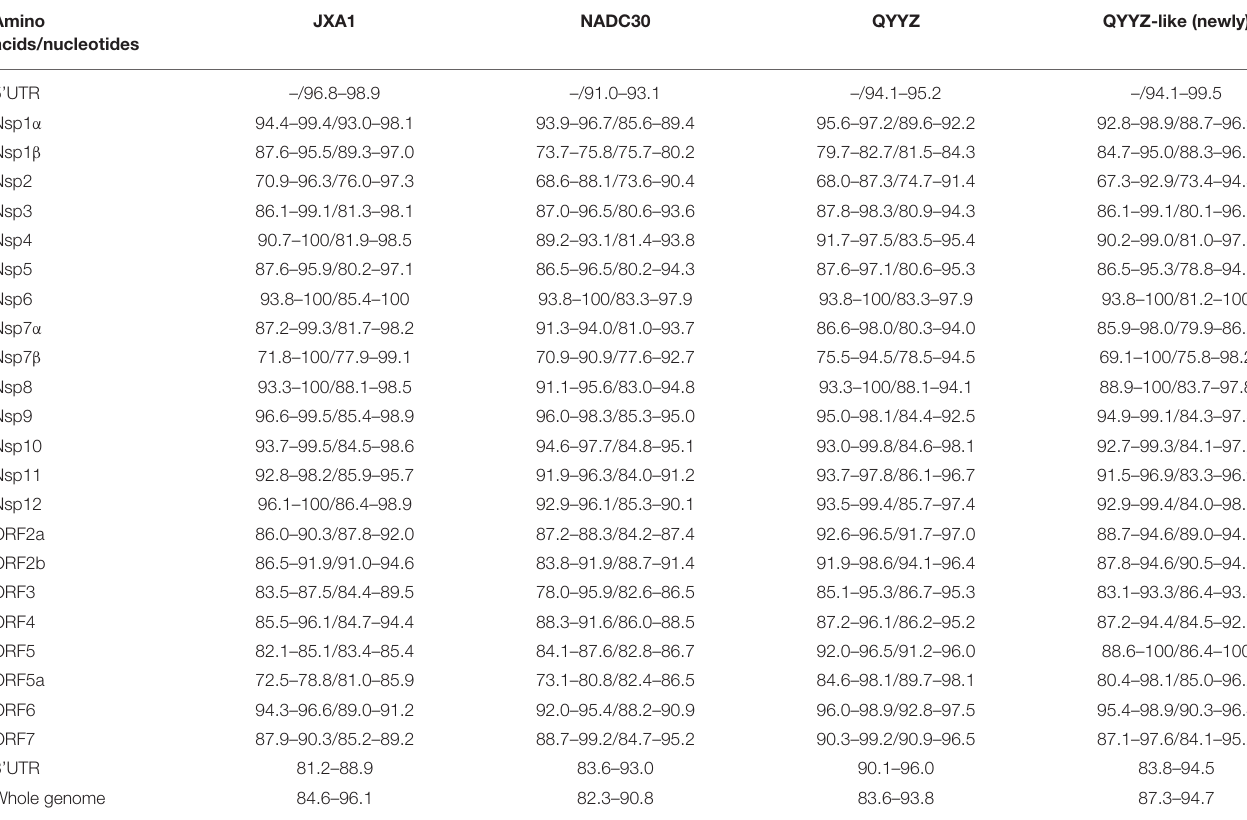
TABLE 2 | Nucleotide and amino acid sequence similarity between the 24 new QYYZ-like PRRSVs and the reference strain. Amino